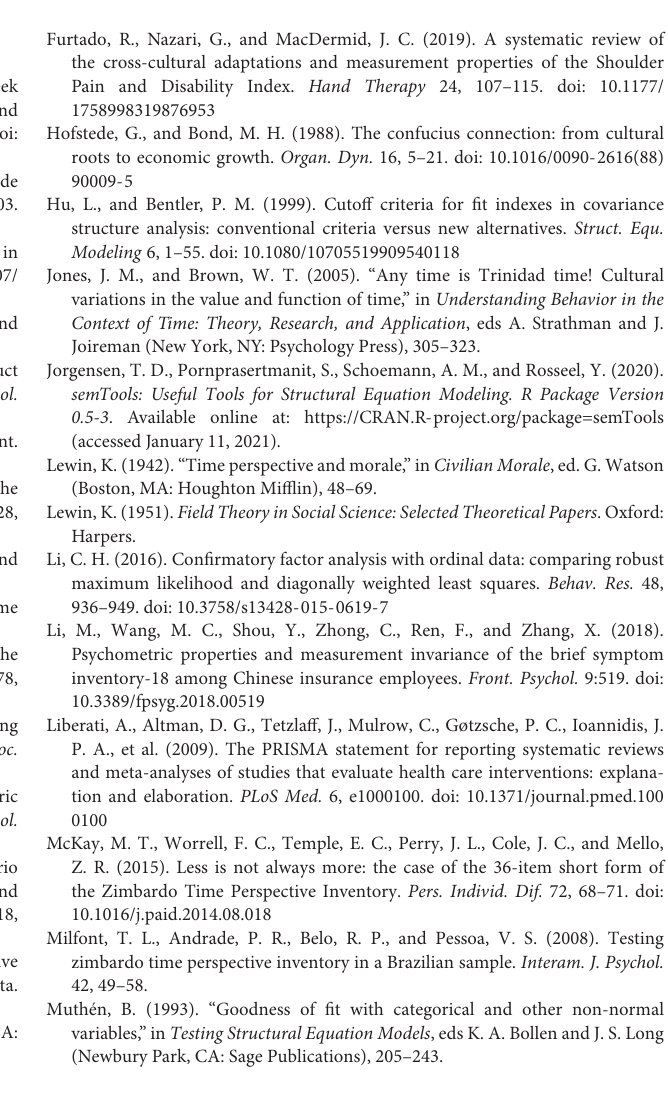
Supplementary Figure 1 | The correlations between item frequencies and factor loadings in samples of (A) Chinese children, (B) undergraduates, and (C) old adults, as well as (D) the merged